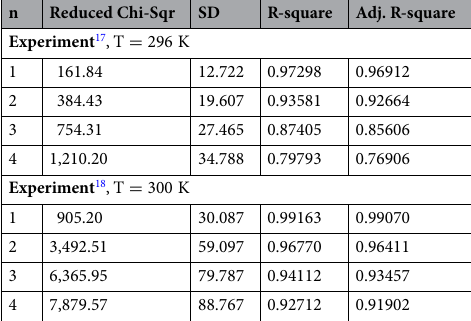
Table 2. The goodness-of-fit parameters obtained during the nonlinear regression analysis of the experimental data. Standard deviation (SD) is equal to the square root of reduced-chi-square.